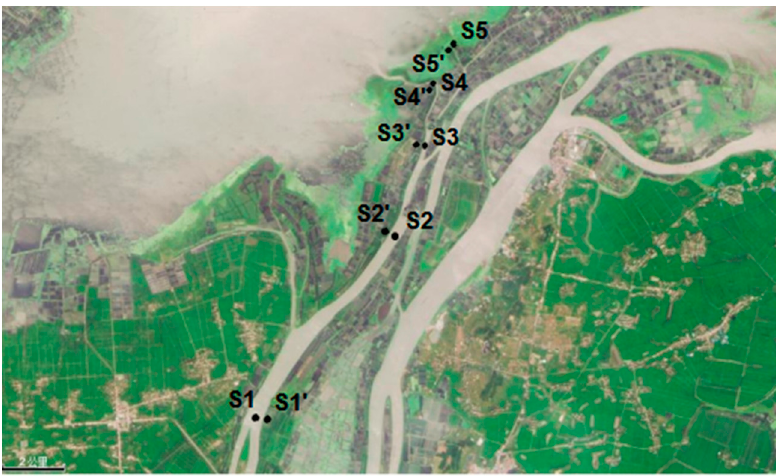
Figure 1. Distribution of sampling points in the estuary.